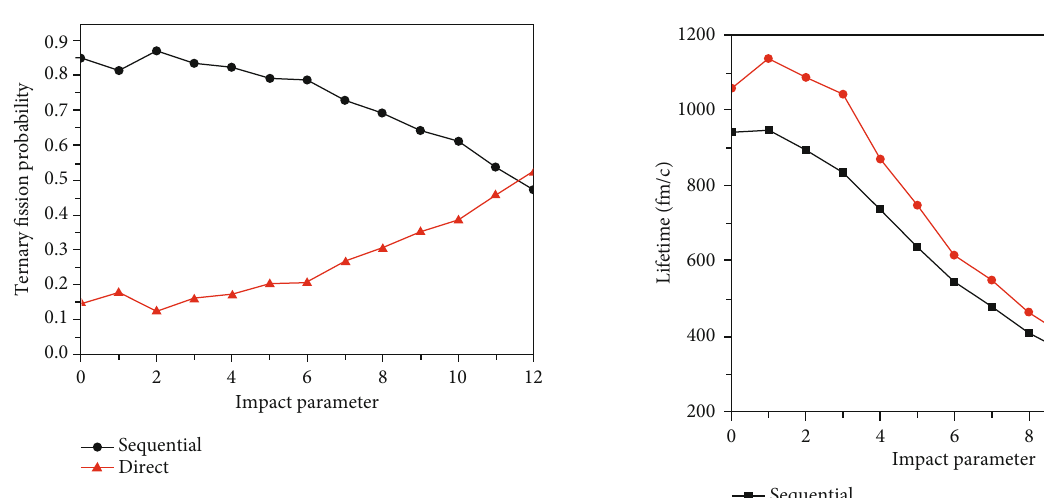
Figure 2: The dependence of the production probabilities about the direct and sequential ternary fi ssions on the impact parameter in 197 Au+ 197 Au system at an energy of 15 MeV/nucleon. Figure 3: Correlation between the lifetime of the new ternary fi ssions and the impact parameter. The black solid-square line is the lifetimes of the composite system of the sequential ternary fi ssion at all impact parameters, and the red solid-dot line represents that of the direct ternary fi